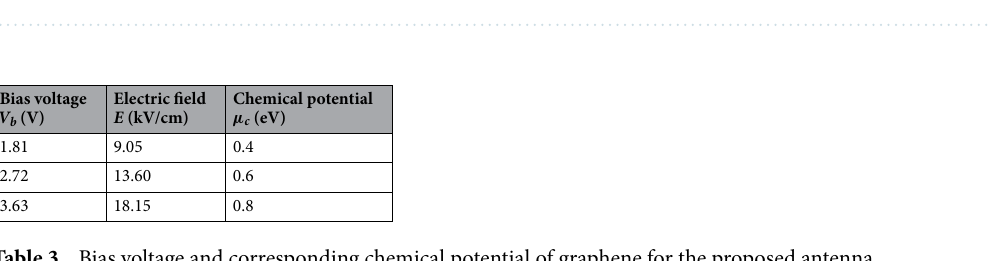
Table 2. Condition for different state elements.